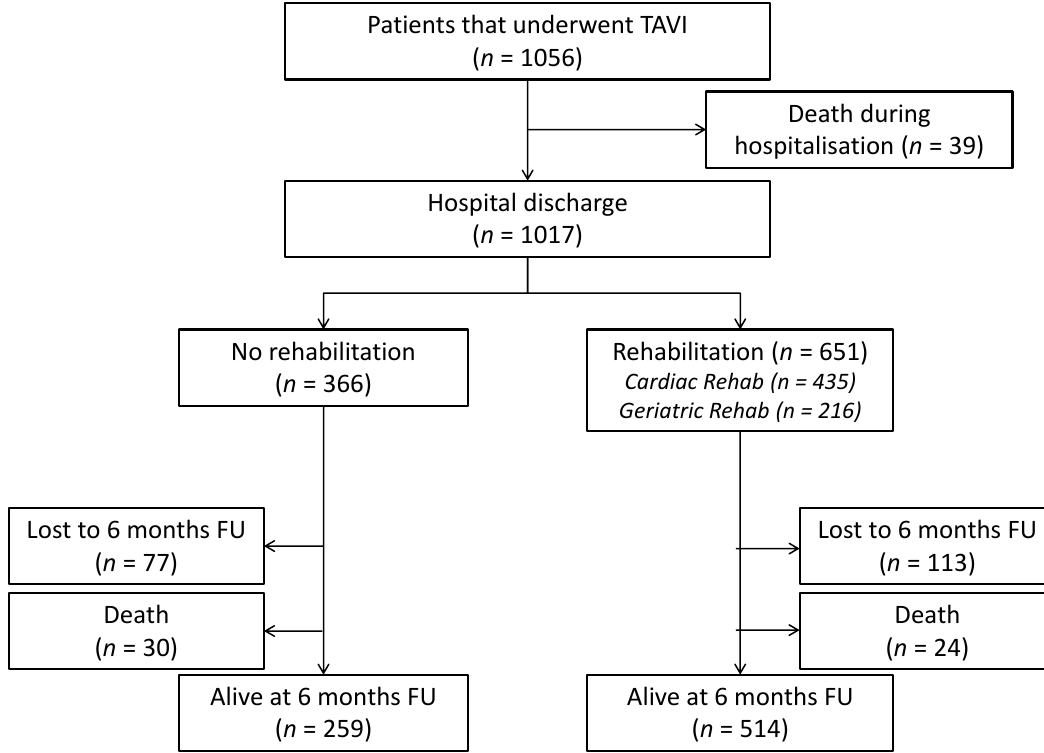
Figure 1. Patient flow through the study. TAVI, transcatheter aortic valve implantation; FU,